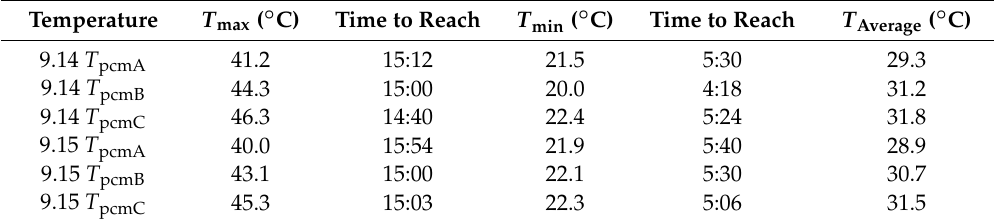
Table 4. Main data of temperature comparison of south-facing wall.